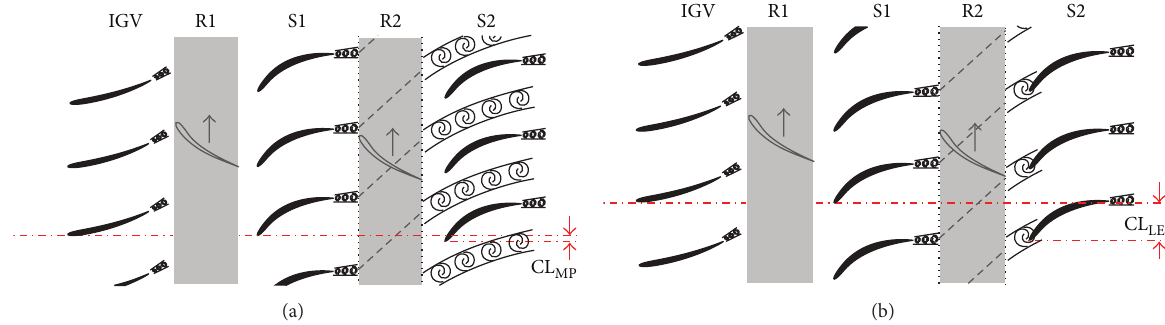
Figure 1: The two clocking configurations studied in detail in the Purdue 3-Stage Research Compressor.